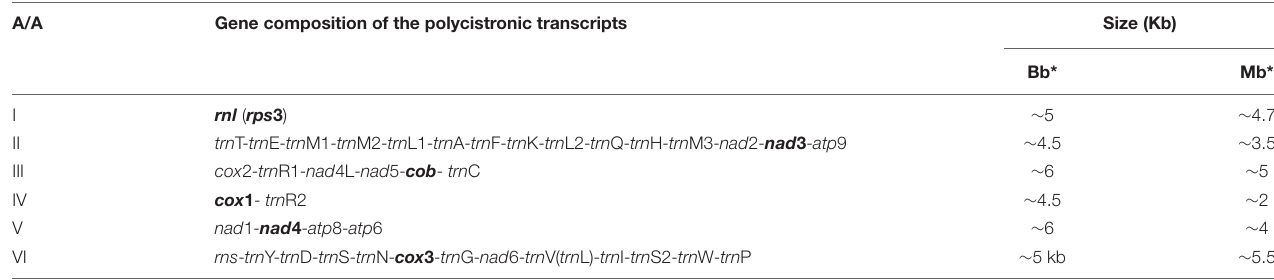
TABLE 4 | Pre-mature polycistronic transcripts and their sizes as produced by the RT-PCR experiments for both B. bassiana and M. anisopliae. A/A Gene composition of the polycistronic transcripts